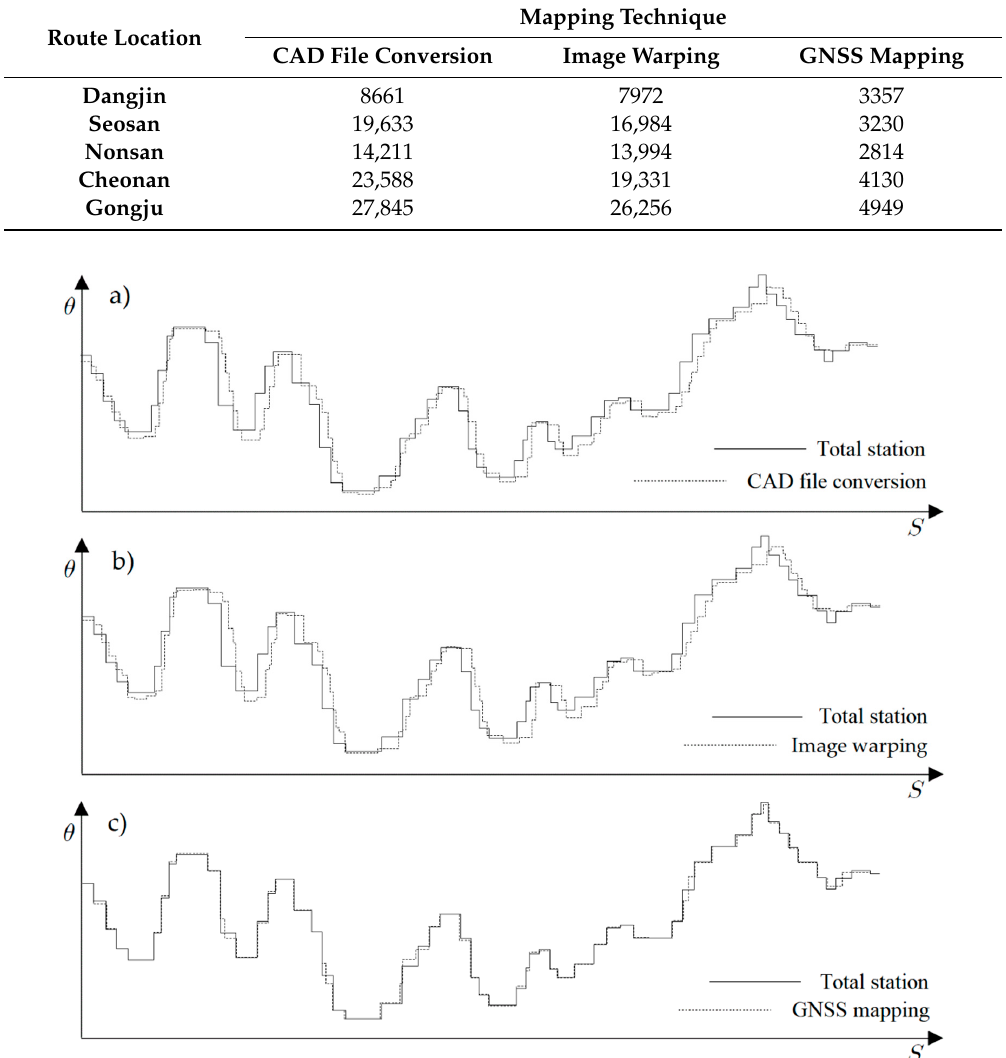
Figure 7. Example of turning function analysis between the three mapping techniques and reference map on Nonsan: ( a ) CAD file conversion, ( b ) image warping, and ( c ) GNSS mapping. map on Nonsan: ( a ) CAD file conversion, ( b ) image warping, and ( c ) GNSS